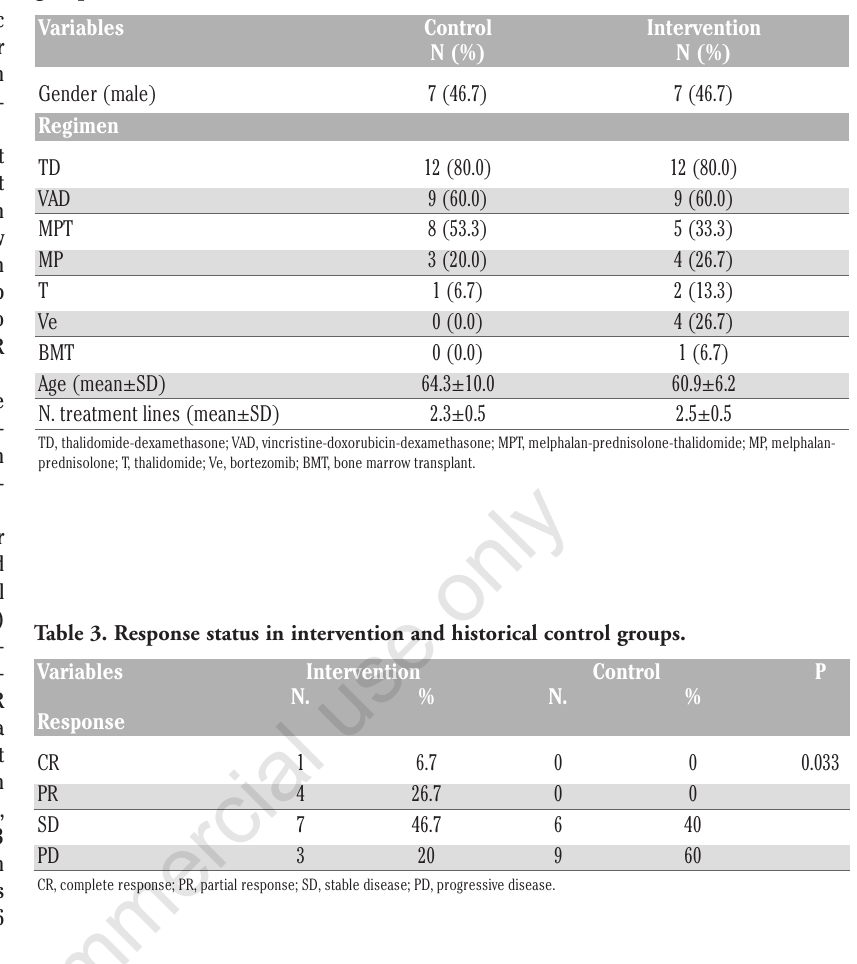
Table 2. Patients’ clinical characteristics in the intervention and in the historical control groups.